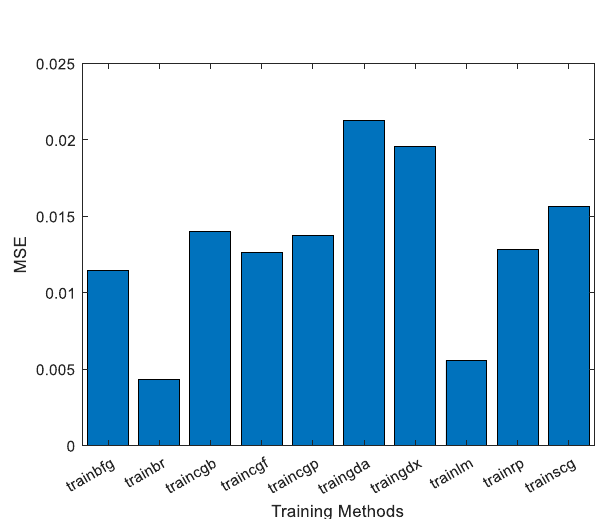
Figure 5. A comparison of error value for different training methods in MATLAB.